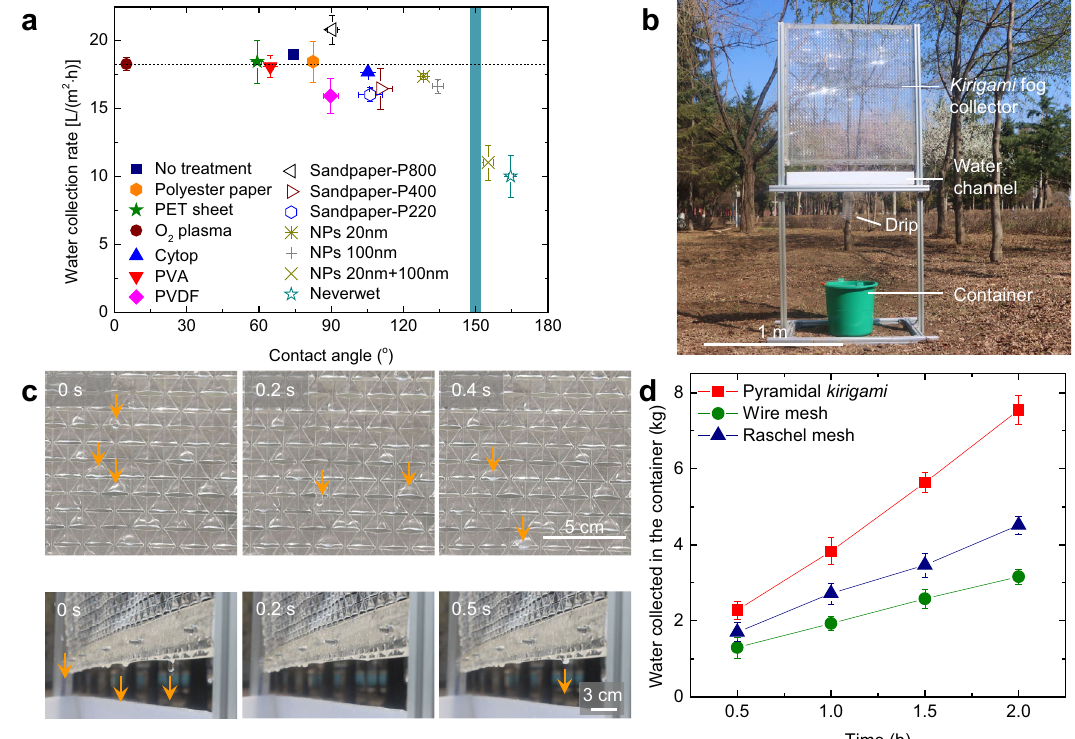
Fig. 4 The stability and scalability of the pyramid kirigami fog collector. a The variation of water collection rates (under a wind speed of 0.8 m/s) on the pyramidal kirigami samples made from different materials and with different surface treatments as a function of water contact angles. b A photo of the large-scale fog collection system. The pyramidal kirigami with unit width of 1 cm is cut and folded from a 1 ×1 m PET sheet. c The selected snapshot images showing the transport (top panel) and dripping (bottom panel) of fog droplets on kirigami collector in the outdoor testing. The experiments were conducted during April 15 – 19, 2021 in Changchun, China with the environmental temperatures ranging of 12 – 19 °C, and the wind speed and humidity near the sample as 2.5 ± 0.8 m/s and 98 ± 1.7%, respectively. d The weight of water collected by the meter-scale kirigami fog collector as the function of time. Fog collections on the wire mesh (wire diameter: 150 μ m, open area: 30%) and Raschel mesh (wire width: 2 mm, shade rate: 50 – 60%) were tested under the same environmental conditions for comparison. Data in ( a , d ) are means ± s.d. of fi ve measurements. Here, θ = Sample preparation . Various cubic and pyramidal kirigami samples are fabricated from Al-coated PET sheet with thickness of 127 μ m. Speci fi cally, the Al-coated PET sheet is cut through along the black solid lines over a length of 17 mm using Cricut ® cutting machine (Explore air 2), leaving a joint with width and length of 3 and 1mm, respectively. To ensure the mechanical robustness of the structure, the edge of joint that connects the adjacent kirigami units, is designed to be round (diameter: 1mm) in order to more evenly distribute the stress during folding 34 . After that, the surface is scored with a smaller force along the red and blue lines, leaving channels with depth of 100 μ m. By alternating the mountain and valley folds along the red and blue lines, respectively, the fl at sheet is folded into 3D and conformable kirigami structures, with the length ( h o ) and width ( w o ) of kirigami unit being 9 and 10 mm, respectively. All the samples are completely washed with ethanol and 2-propanol sequentially, followed by dip-coating with a diluted Cytop ® CTL-109AE solution (mixed with solvent, Fluorinert ™ FC-3283, at a mass ratio of 1:50) at a speed of 3mm/s. Finally, all the samples are baked at 100 °C for 20 min to completely remove the Fluorinert ™ FC-3283. The treated surfaces are characterized by water goniometer (Ramé-hart instrument Co.) with a water contact angle of 105.3 ±1.1° and a contact angle hysteresis (the difference between advancing and receding contact angles) of 9.2± 1.3°, averaged over 5 measurements.